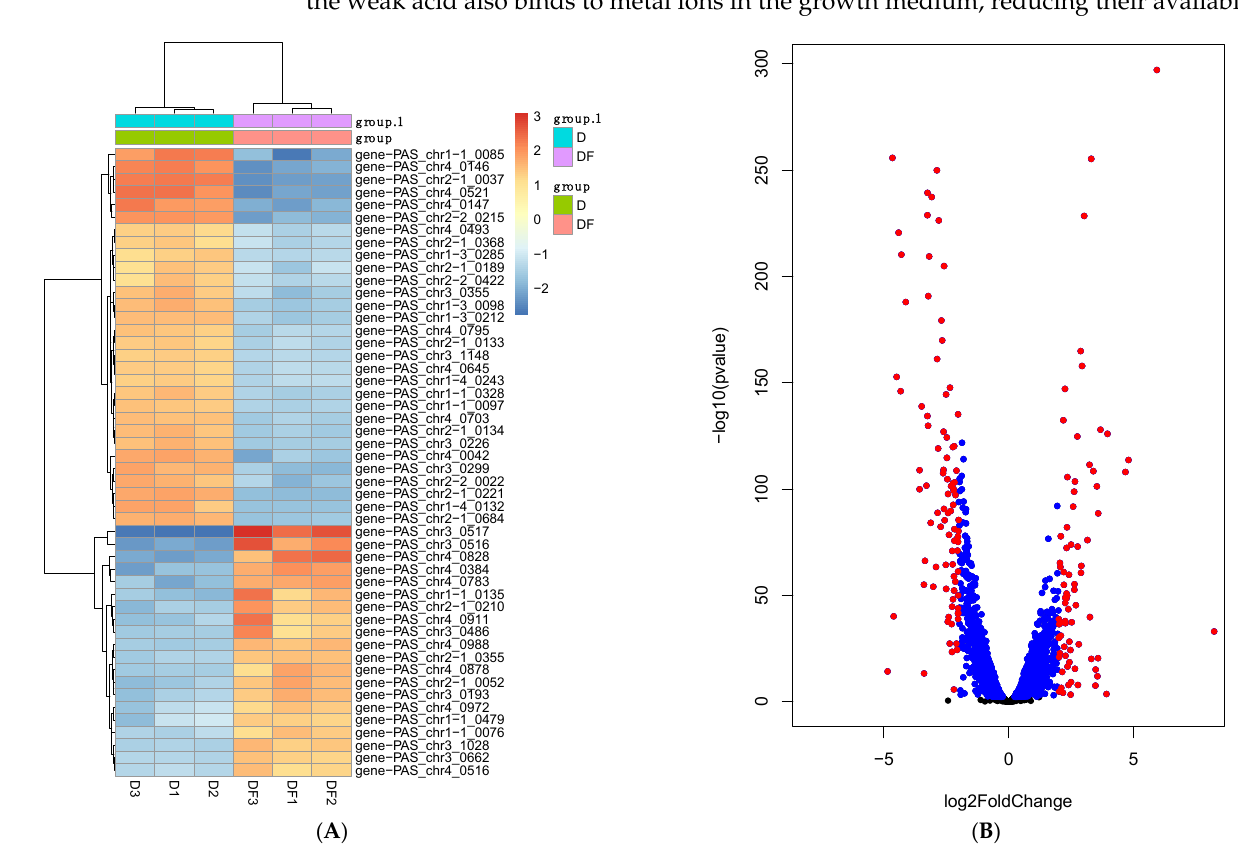
Figure 6. Gene expression heatmap ( A ) and a volcano plot ( B ) of D -lactic acid-producing Pichia pastoris with (DF1-3) or without (D1-3) ScFLO1 overexpression. Previous studies have shown that S. cerevisiae ’s response to weak acids is complex and varies based on the type of acid, with cell-wall function, protein folding, lipid metabolism, and multidrug resistance being the consistently affected biological functions [26,57,58].